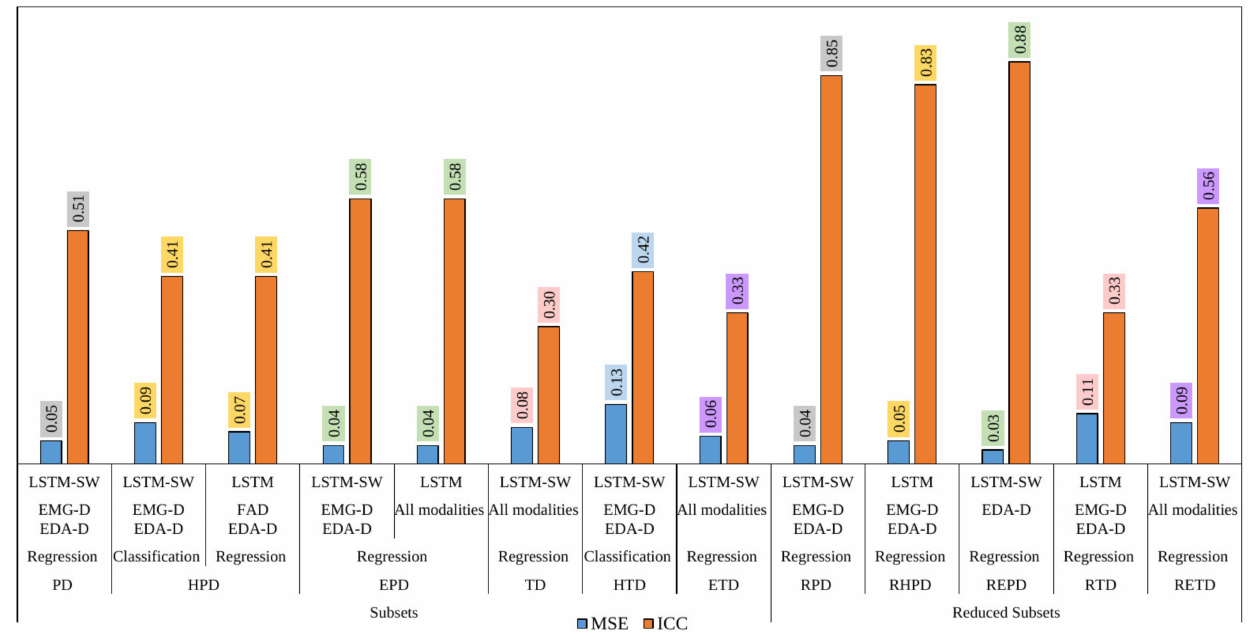
Figure 2. The best results of applying Uni-, Bi, and Multi-modality using RF, LSTM, and LSTM-SW regarding classification and regression in terms of MSE and ICC measures. Numbers with the same background color were used to easily highlight the improvement in the performance of each dataset before and after the reduction strategy was